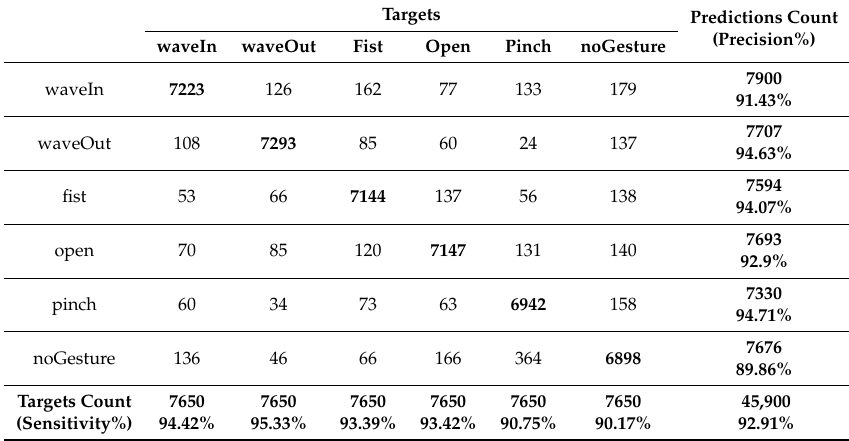
Table A9. Confusion matrix for experiment 3 . Synchronization gestures ( sync = 2 )